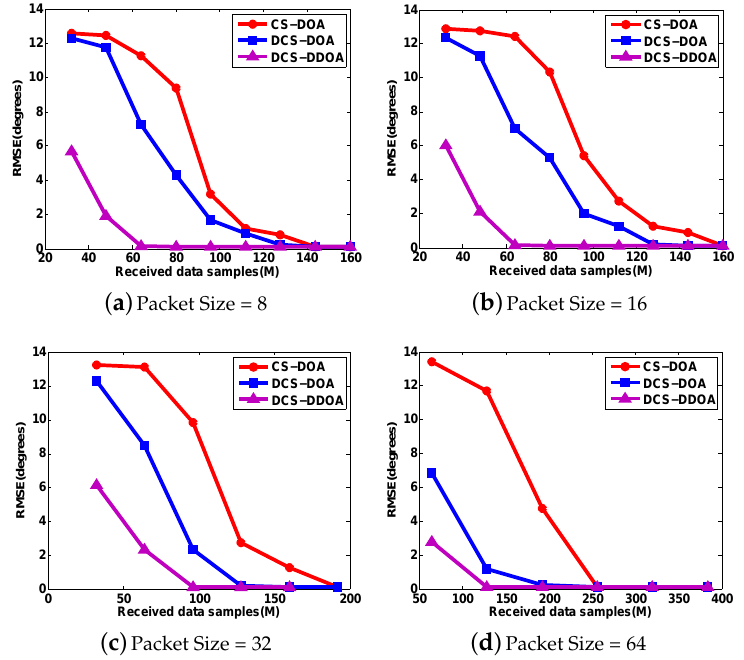
Figure 16. The comparison of DOA estimation RMSE among CS-DOA, DCS-DOA, DCS-DDOA under different packet